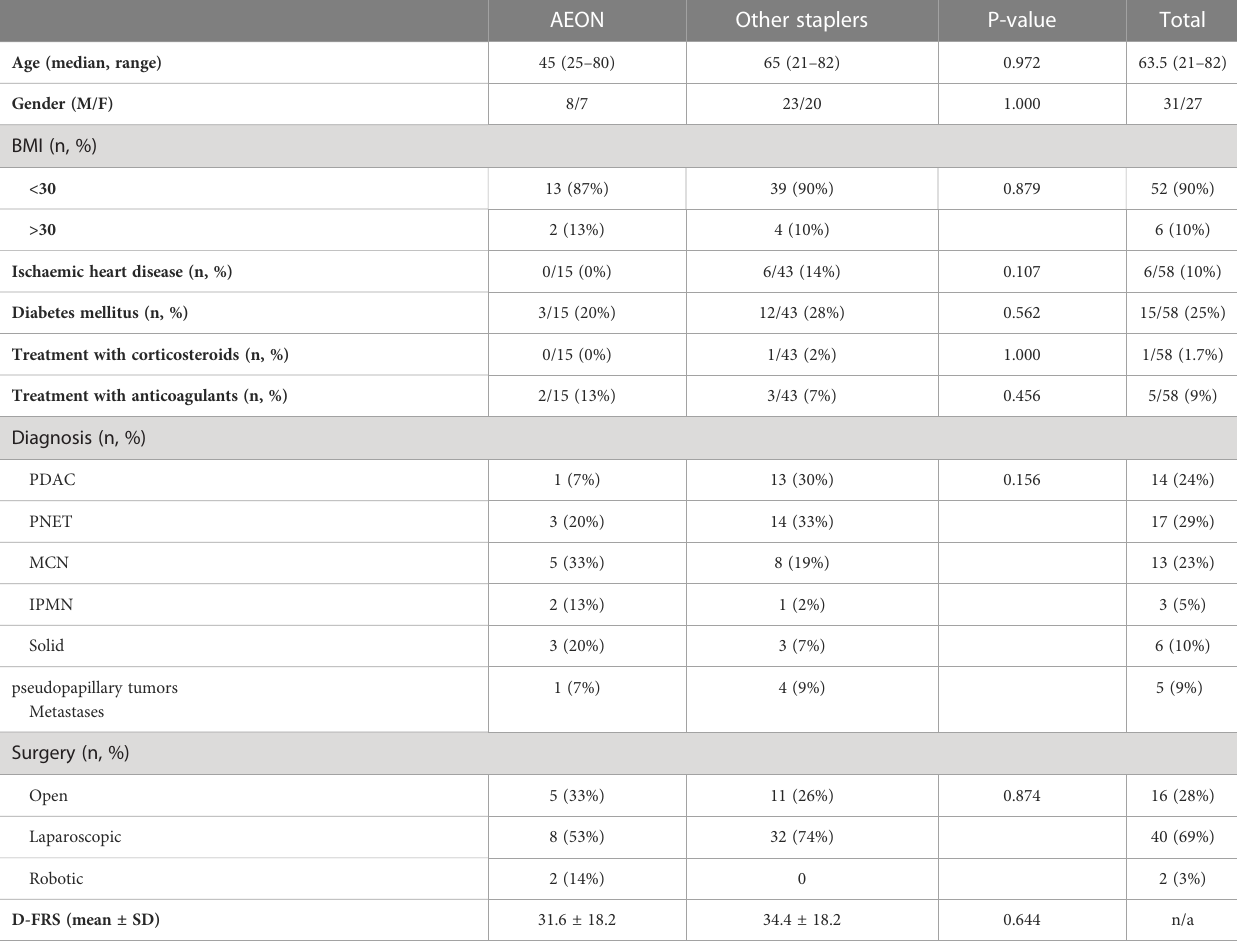
TABLE 1 Patients ’ demographics and disease pro fi